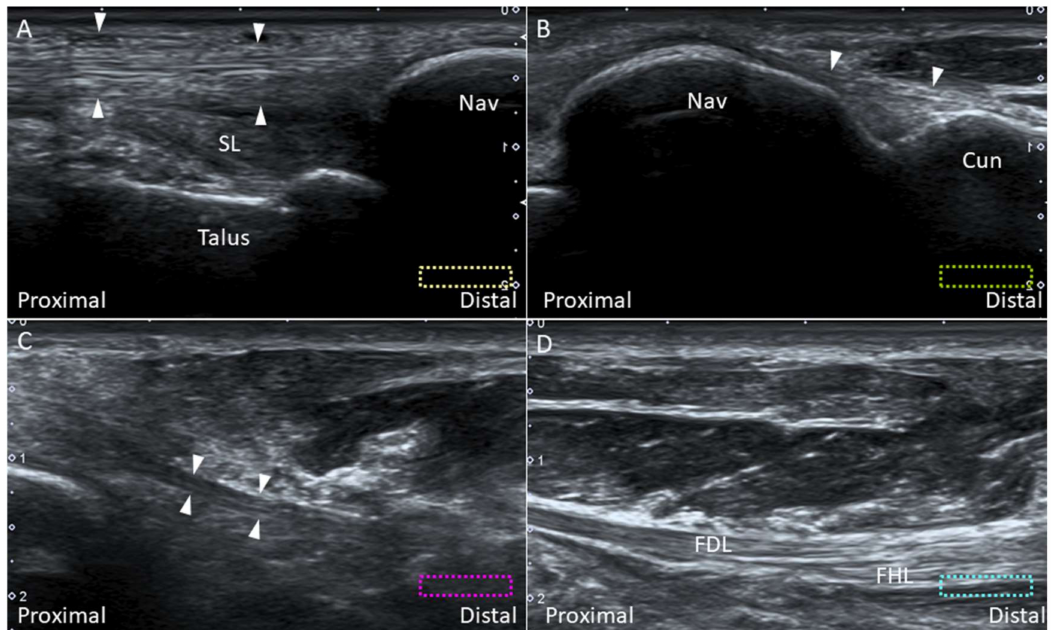
Figure 21. Imaging of the insertion of the direct limb of the tibialis posterior tendon (arrowheads) on the navicular ( A ) and medial cuneiform ( B ) bones and the tarsometatarsal portion of the tibialis posterior tendon ( C ). Moving the transducer to the plantar aspect of the sole, the knot of Henry can be seen ( D ). The colored dashed rectangles are in accordance with the transducer positions in Figure 3A,B. Cun: medial cuneiform; FDL: flexor digitorum longus tendon; FHL: flexor hallucis longus tendon; Nav: navicular; SL: spring